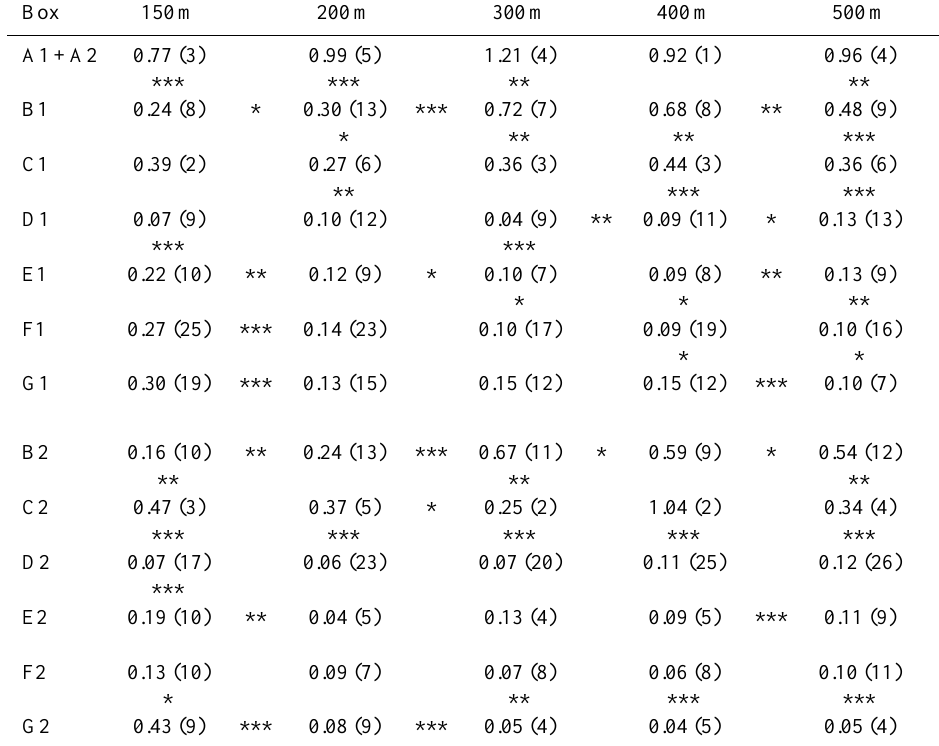
Table 1. Median O 2 concentrations (mLL − 1 ) for all boxes near the indicated depths (number of values in parentheses; data in Table S.1.b). One-sided p for O 2 difference between adjoining medians: * ≤ 0.20; ** ≤ 0.10; *** ≤ 0.05); blank, non-significant.